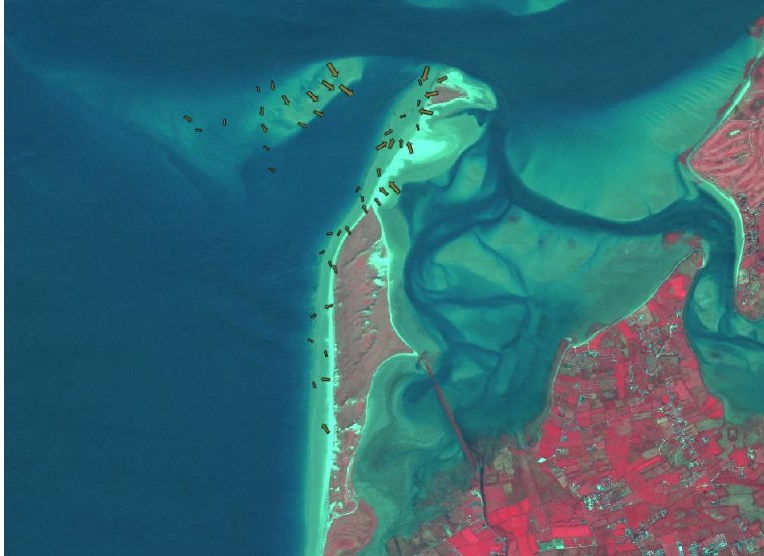
Figure 9. CP − trend. Figure 9. CP ´